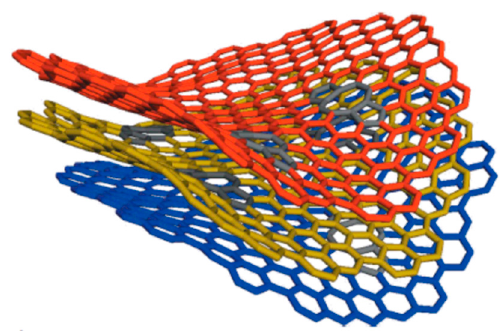
Figure 36. Visualization of the structural model with di-vacancies defects for graphene flakes obtained by chemical exfoliation of graphite. The visible defects are indicated by grey non-hexagonal rings. Reproduced with permission from Woznica et al. [24]. Copyright International Union of Crystallography, 2015.